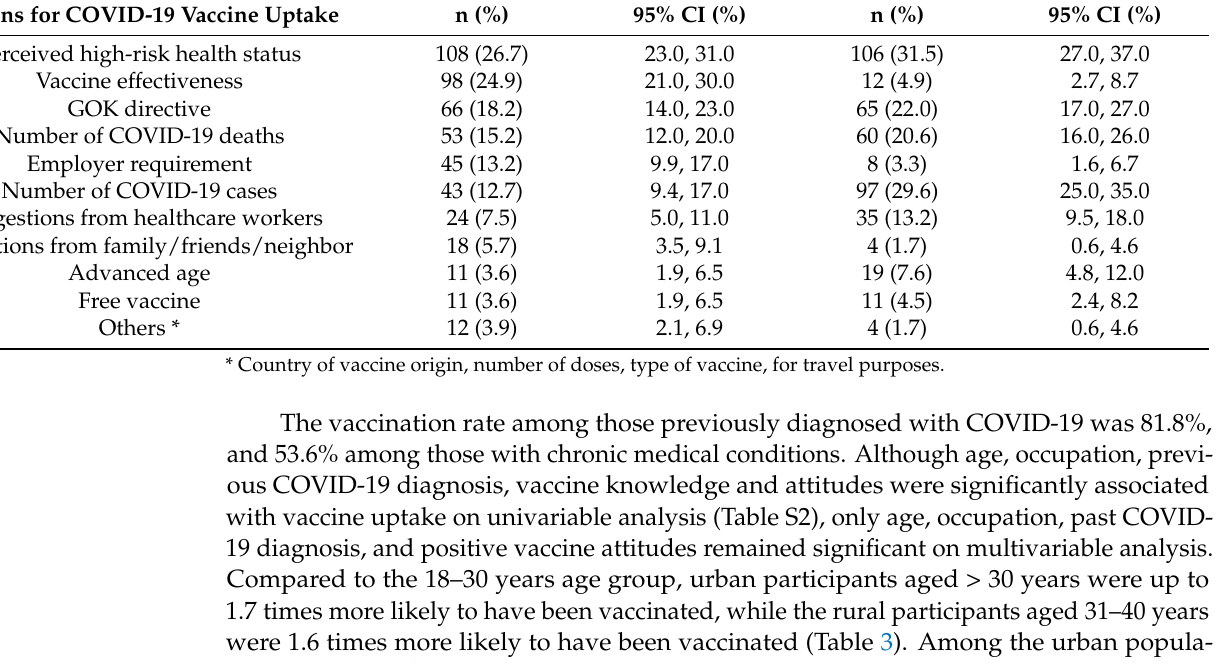
Table 2. Reasons for COVID-19 vaccine uptake among vaccinated urban and rural study participants. Urban Participants, N = 326 Rural Participants, N = 262